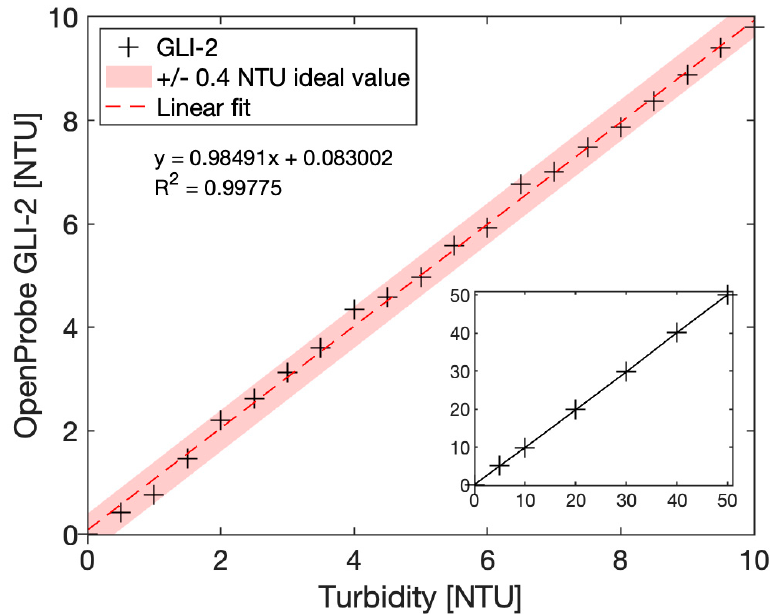
Figure 10. Calibrated OpenProbe GLI-2 sensor immersed in Formazin calibration solutions from 0 to 10 NTU (main graph) and 0 to 50 NTU (inset). A confidence interval of +/ − 0.4 NTU was obtained in the 0 to 10 NTU range.